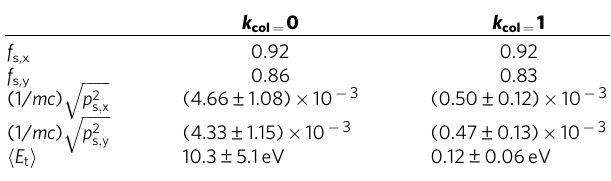
Table 2 | Summary of the r.m.s. beam size (fraction) at the source evaluated from the beam image, the r.m.s. transverse velocity, and the average transverse beam energy. k col ¼ 0 k col ¼ 1